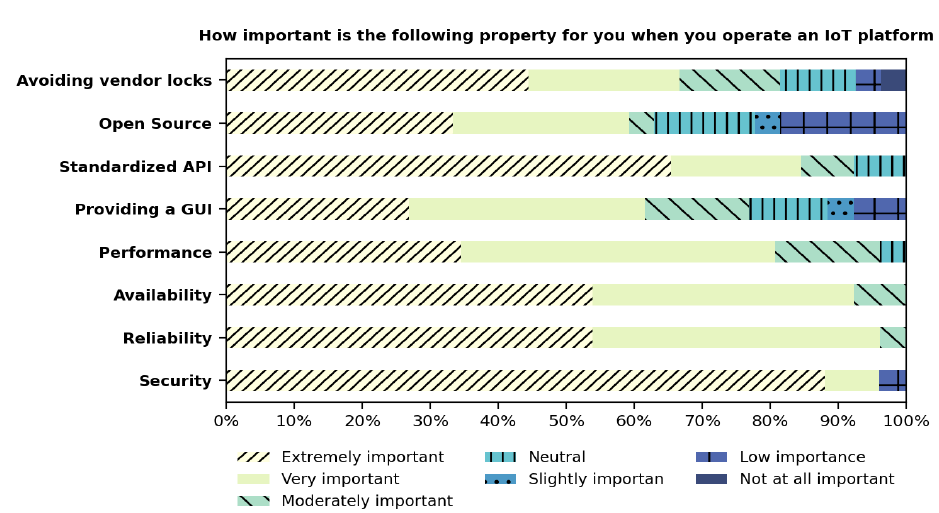
Figure 5. Responses to a survey question show the scalability of the application in which the IoT platform is used/planned to be used.